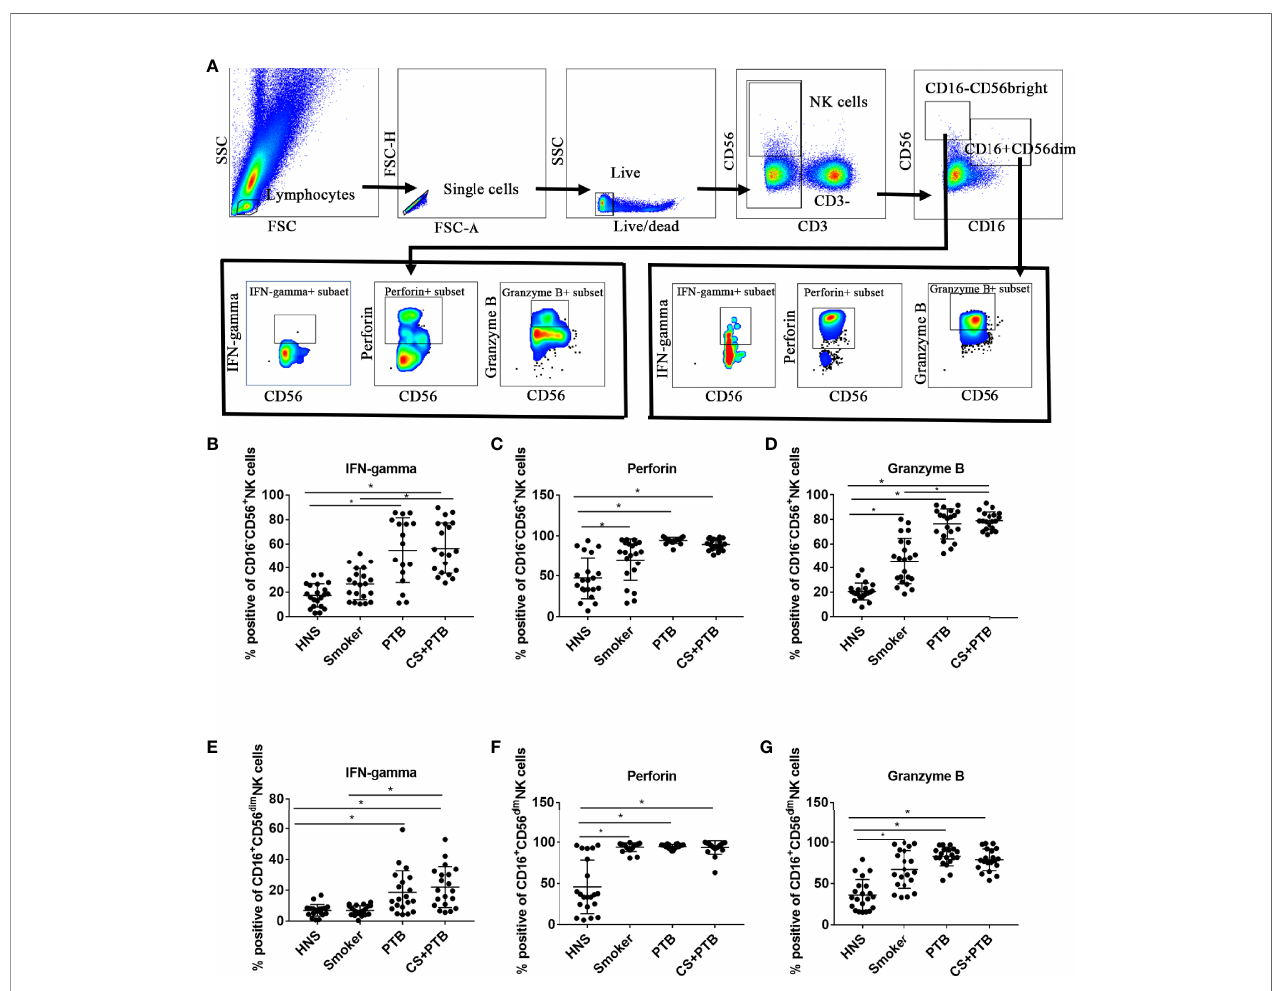
FIGURE 2 | Increased proin fl ammatory cytokine production in both CD16 - CD56 bright and CD16 + CD56 dim NK-cell subpopulations in CS+PTB patients. (A) Flow cytometry gating strategy for identi fi cation of peripherial blood NK cell and cytokine production. (B – D) IFN-gamma + , perforin + , and granzyme B + NK cell within CD16 − CD56 bright NK-cell subpopulation were detected by fl ow cytometry. (E – G) IFN-gamma + , perforin + , and granzyme B + NK cell within CD16 + CD56 dim NK-cell subpopulation was detected by fl ow cytometry. One-way analysis of variance (ANOVA) with Bonferroni or Dunnett ’ s T3 posttest analysis was performed for comparisons between multiple groups. * p <